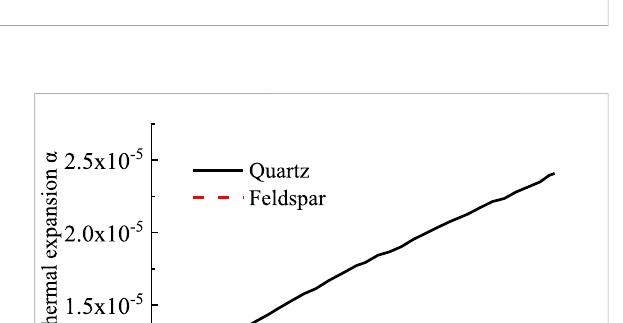
FIGURE 1 Mechanics change of crystal after thermal expansion.